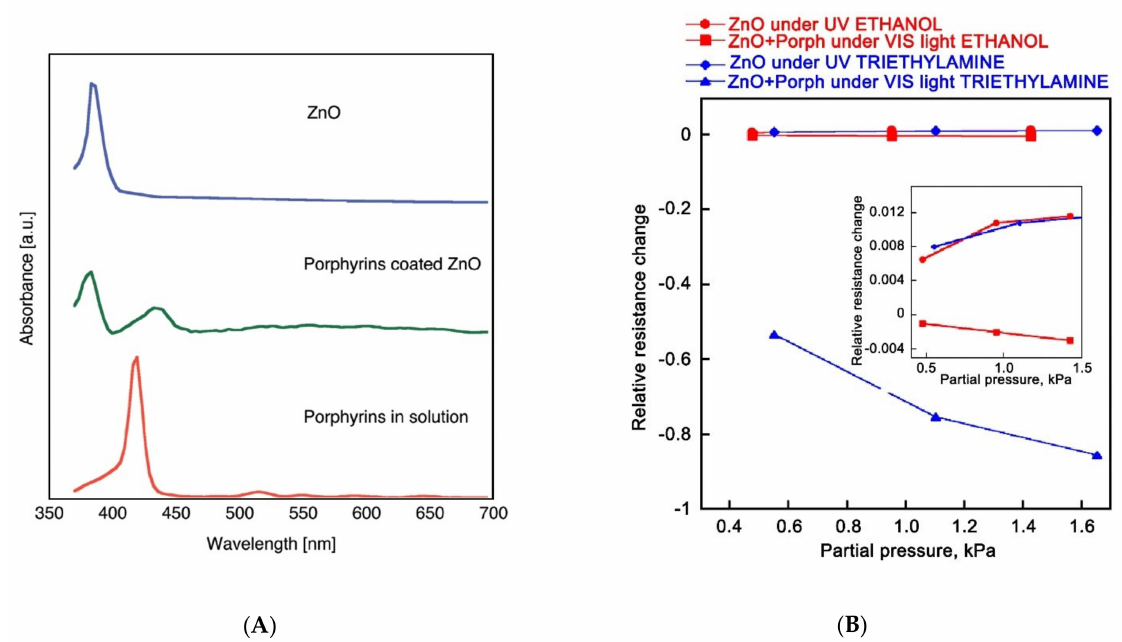
Figure 7. ( A ) Absorbance spectra of pure ZnO, porhirin-coated ZnO, and porphyrins in solution. ( B ) Resistive change at gas sensing measurements of pure and porphyrins-coated ZnO to ethanol and thimethylamine under light illumination. Adopted from [136] with permission from the American Chemical Society,